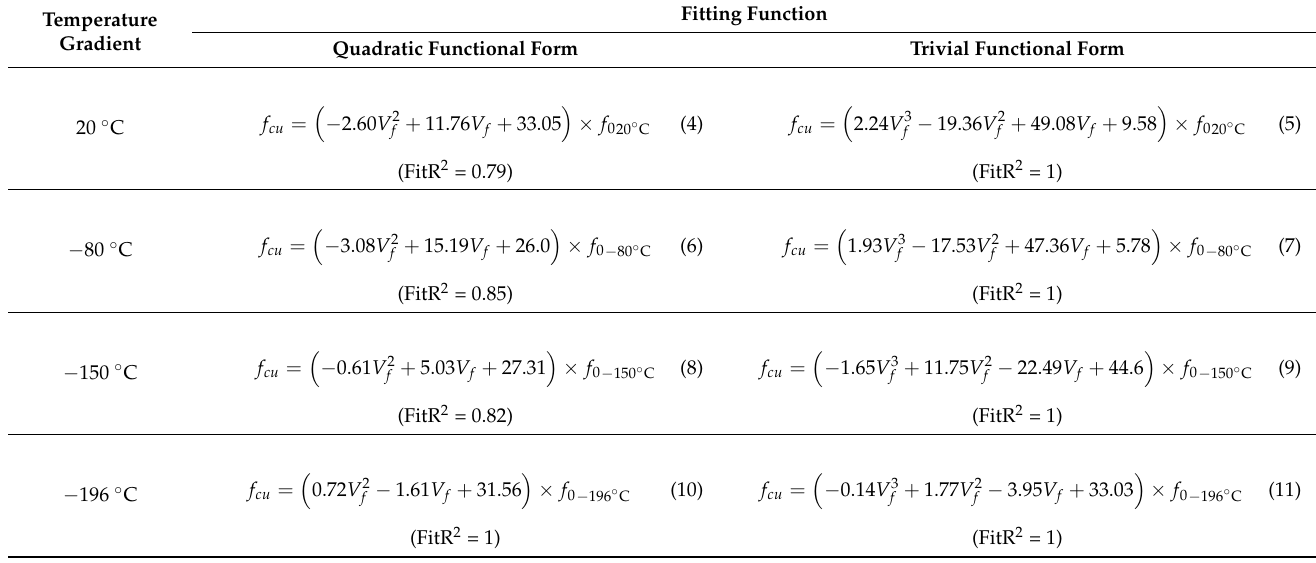
Table 5. Fitted functions of compressive strength with different fiber volume fractions and different temperature